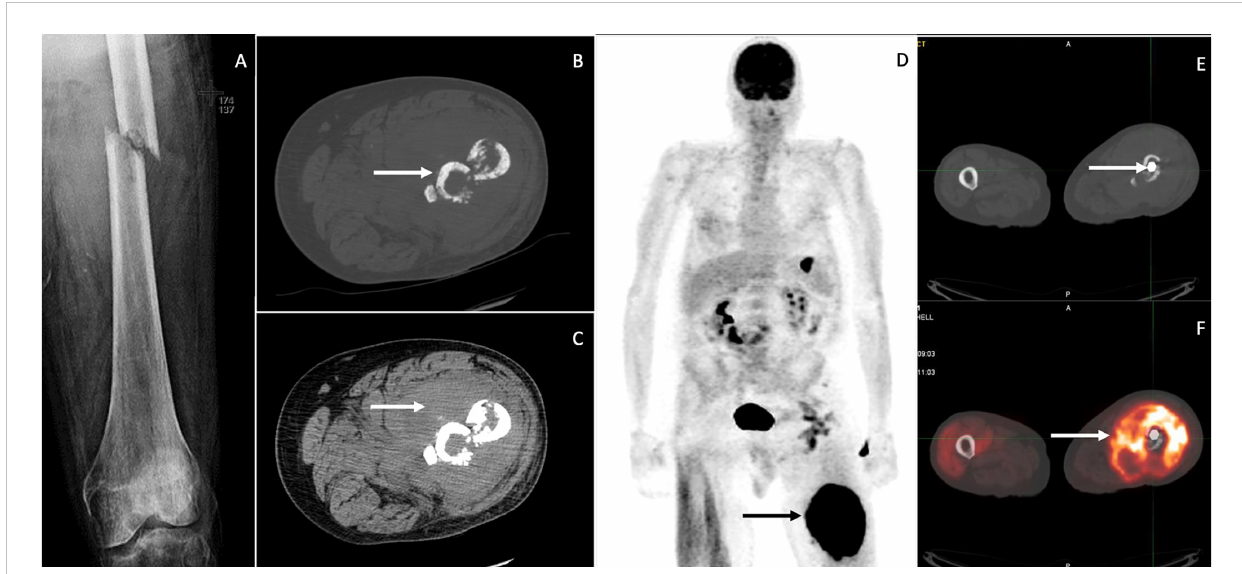
FIGURE 1 X-ray demonstrates displaced mid femoral pathologic fracture through a permeative lesion with improved alignment and diffuse osteopenia (A) . Axial images from CT of the left lower extremity showing a pathologic fracture involving the left proximal femur with sclerotic and fragmented bones (arrow in (B) , and a large heterogeneous soft tissue density mass surrounding the bone fragments (arrow in (C) . Whole-body image from the FDG PET/CT scan (D) shows intense hypermetabolism in the left thigh mass, consistent with neoplastic involvement. Other foci of increased uptake were thought to be non-neoplastic. The pathologic fracture has been internally fi xed with an intramedullary nail (arrow in (E) , and the axial fused PET/CT image shows intense hypermetabolism in the mass surrounding the proximal femur (arrow in (F)